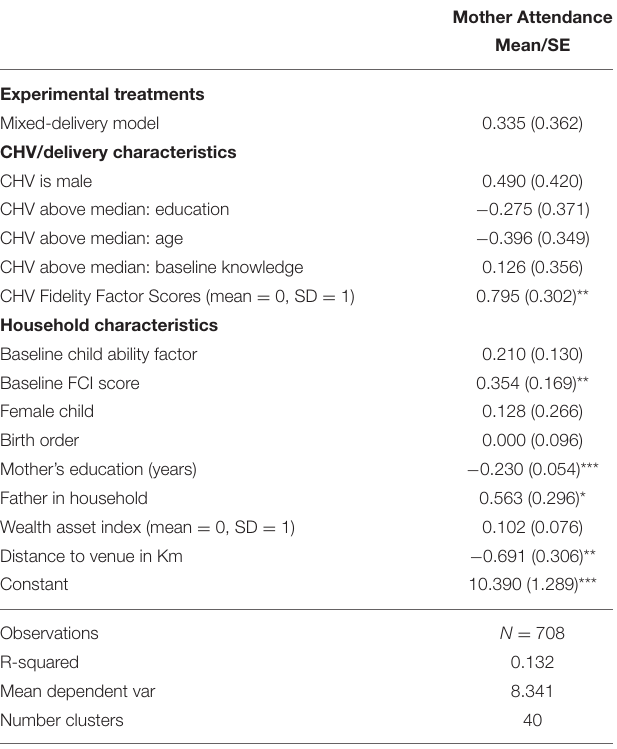
TABLE 4 | Determinants of maternal attendance to common group sessions.